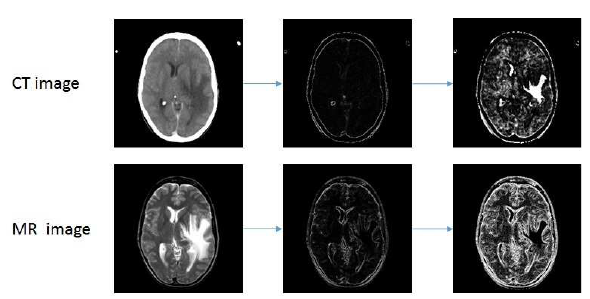
Figure 3. Structure extraction